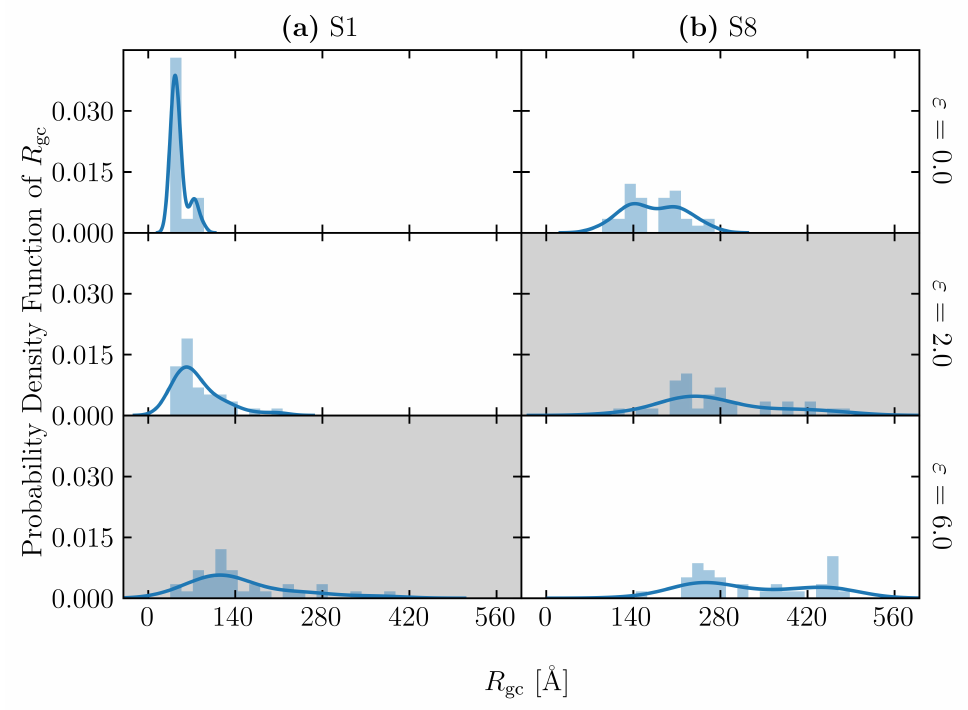
Figure 9. Distributions of chain’s radius of gyration R gc of ( a ) S1 and ( b ) S8 at three different strains: 0.0 (initial state), 2.0 and 6.0. The solid lines are density estimation using the kernel to smooth the frequency over the bins. Gray backgrounds indicate the strain at break of each structure (2.0 for S1 and 6.0 for